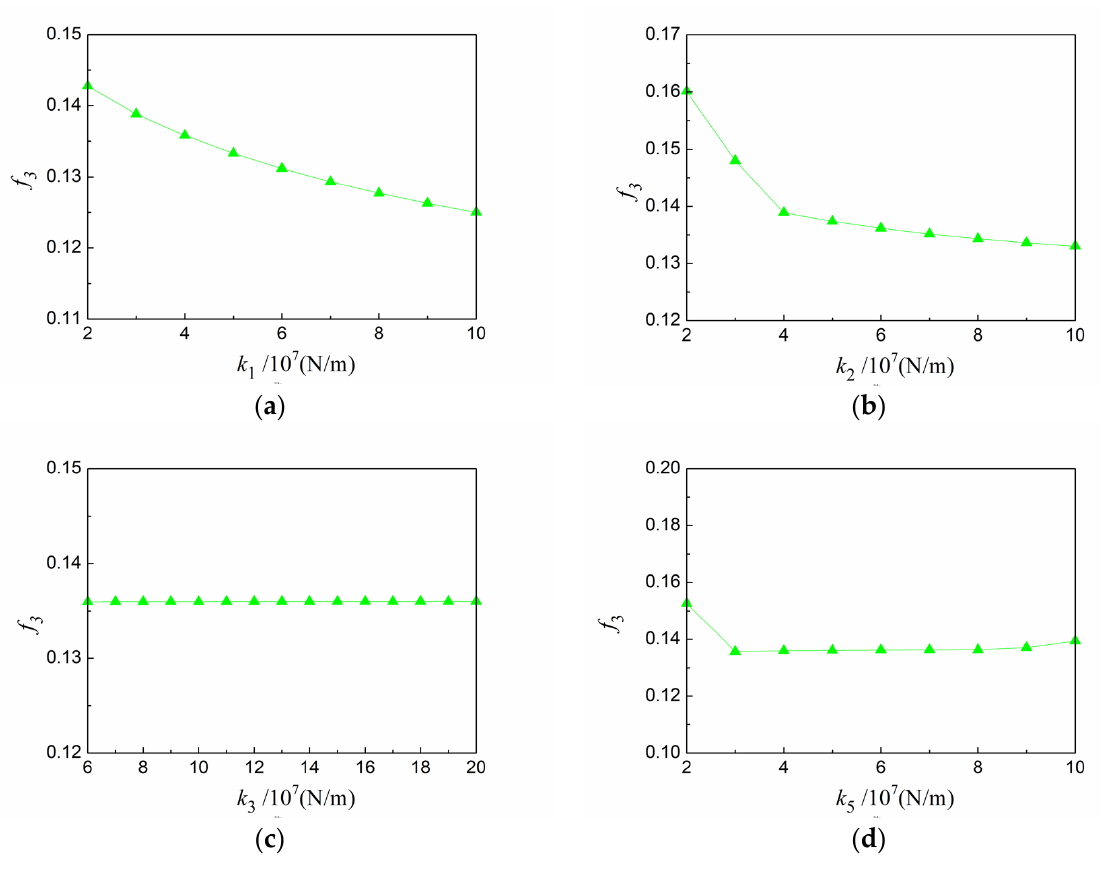
Figure 15. Effect of stiffness change of each support on f 3 . ( a ) Effect of support 1 stiffness on f 3 ; ( b ) effect of stiffness of support 2 on f 3 ; ( c ) effect of stiffness of support 3 on f 3 ; ( d ) effect of stiffness of support 5 on f 3 .